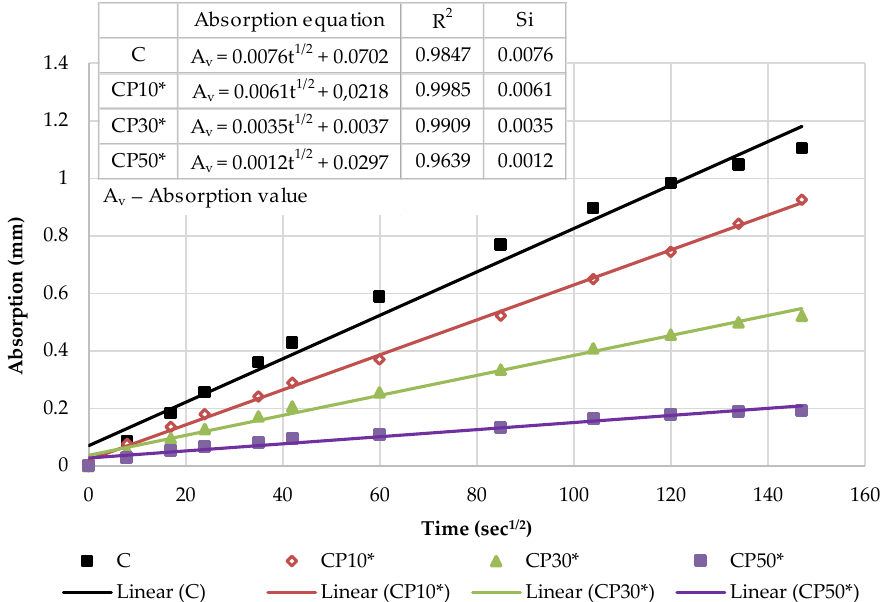
Figure 18. The initial capillary absorptivity of CP–based mortars with decreased w/b.